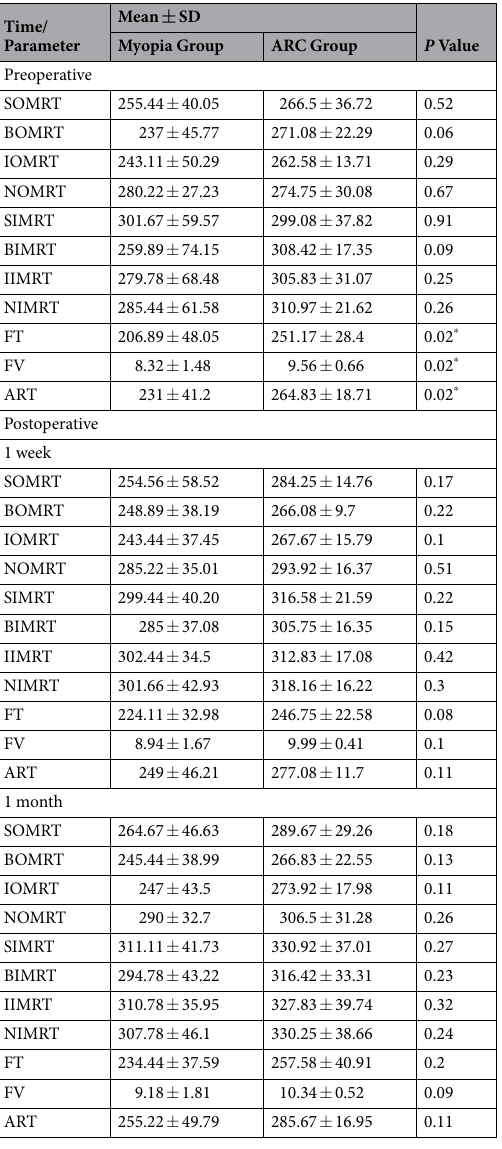
Table 2. Retinal Thickness Values After Femtosecond Laser–assisted Phacoemulsification. SOMRT = superior outer macular ring thickness; BOMRT = bitamporal outer macular ring thickness; IOMRT = inferior outer macular ring thickness; NOMRT = nasal outer macular ring thickness; SIMRT = superior inter macular ring thickness; BIMRT = bitamporal inter macular ring thickness; IIMRT = inferior inter macular ring thickness; NIMRT = nasal inter macular ring thickness; FT = foveal thickness; FV = foveal volume; ART = average retinal thickness, * P <